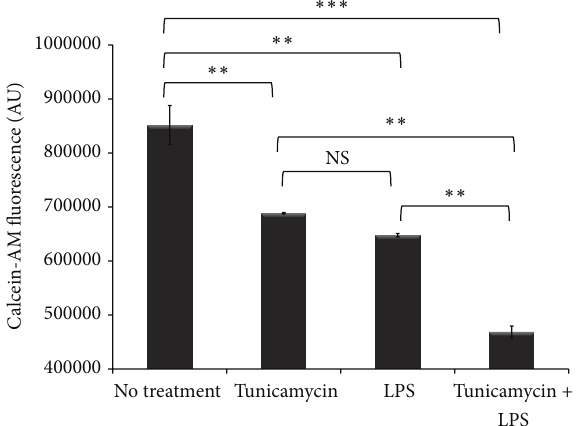
Figure 4: ER stress and inflammation induce iron retention in macrophages. THP-1 cells ( 1 × 10 6 cells/mL) were treated with tunicamycin (10 𝜇 g/mL) or DMSO overnight prior to LPS exposure (40ng/mL) for 6 hr and iron retention in macrophages was determined using the calcein-AMfluorescentprobemethod[40].DMSOtreatedcellswereincubatedsimultaneouslyandusedascontrols.Calcein-AMfluorescence wasmeasuredbyexcitationat488 nmandemissionat528 nmwavelength(see Section 2).Calcein-AMfluorescenceisquencheduponbinding iron and is therefore inversely correlated with intracellular iron accumulation. AU: arbitrary units. Error bars represent the SD from the mean of triplicate reading and data are representative of two independent experiments. 𝑃 values were calculated in reference to vehicle (DMSO) treatment control using one-way ANOVA followed by Bonferroni multiple comparisons post hoc analysis. 𝑃 values annotated ∗∗∗ 𝑃 < 0.0001 ; ∗∗ 𝑃 = 0.001 – 0.01 ; ∗ 𝑃 = 0.01 – 0.05 ; 𝑃 > 0.05 were not significant